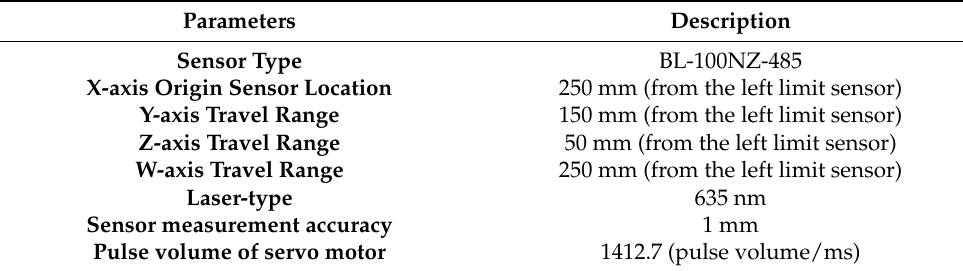
Figure 16. Prototype design drawing. Table 2. Prototype Mechanical